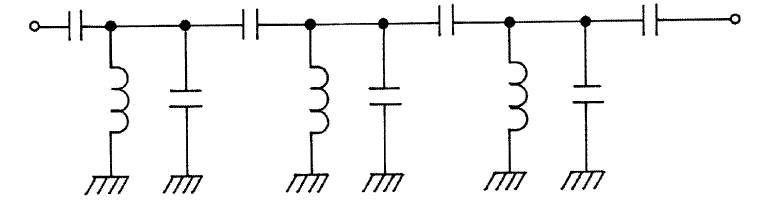
FIGURE 2 Third-order Tchebyshev conventional filter.